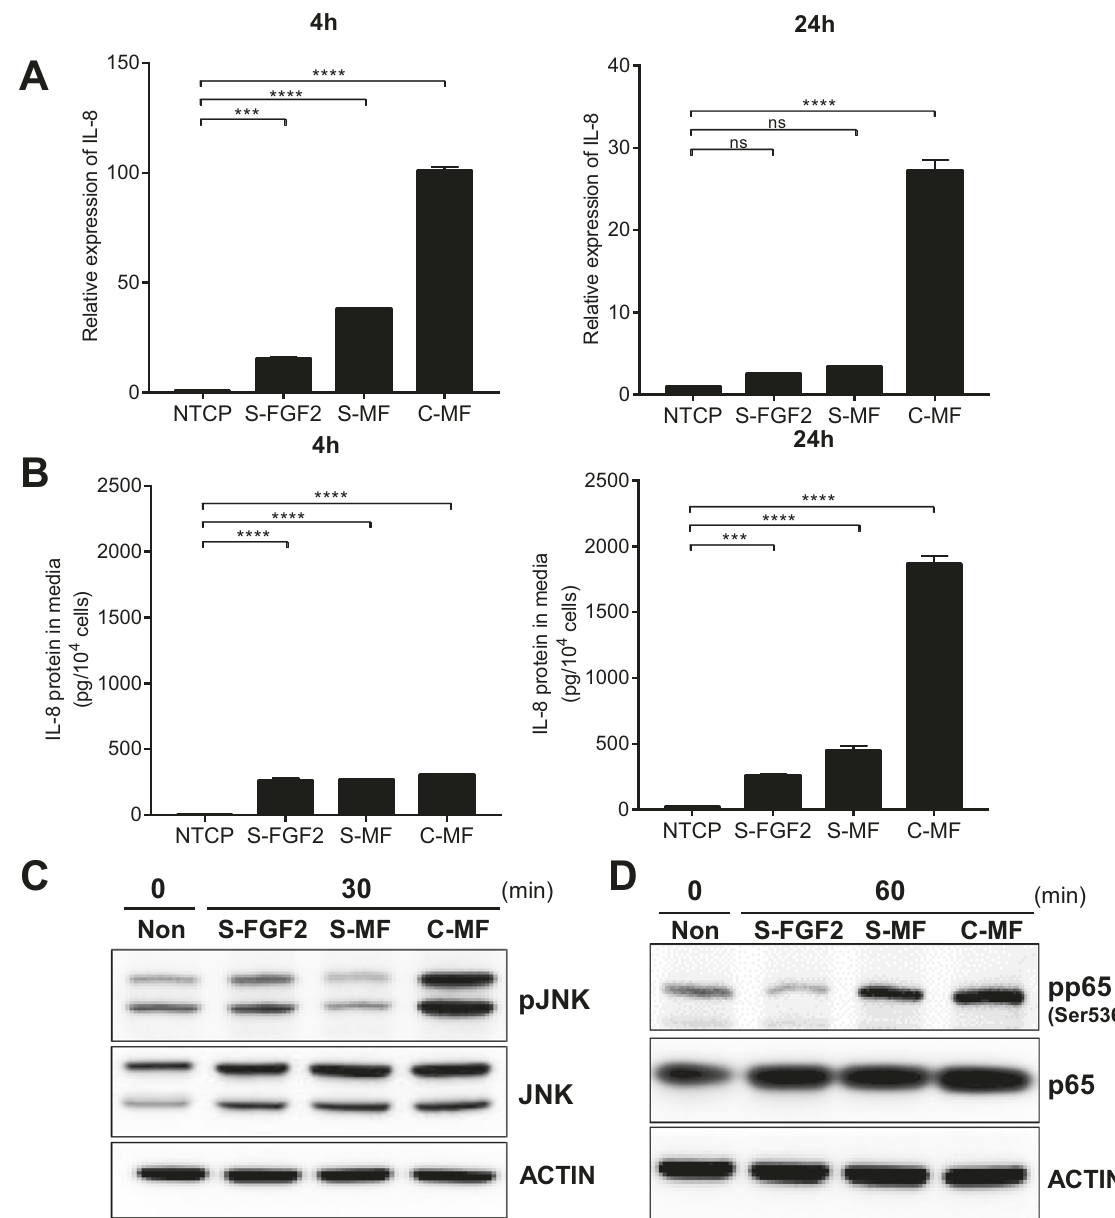
Fig. 5 Enhanced JNK-NF- κ B signaling and IL-8 expression on MBP-FGF2 matrix. hASCs were cultured on MBP-FGF2 surface, or treated with soluble form of FGF2, or MBP-FGF2 proteins. Total RNAs, proteins, and conditioned medium were prepared and analyzed by RT-qPCR, western blot, and ELISA, respectively. A Effect of various FGF2 ligands on IL-8 RNA. Values were normalized to GAPDH. ns not signi fi cant, *** p < 0.001, **** p < 0.0001 (one-way ANOVA), n = 3 per group. B Effect on IL-8 protein. *** p < 0.001, **** p < 0.0001 (one-way ANOVA), n = 3 per group. C Effect on JNK phosphorylation. D Effect on p65 phosphorylation. For western blot analysis, β -actin was used as a loading control. All data are presented as mean ±